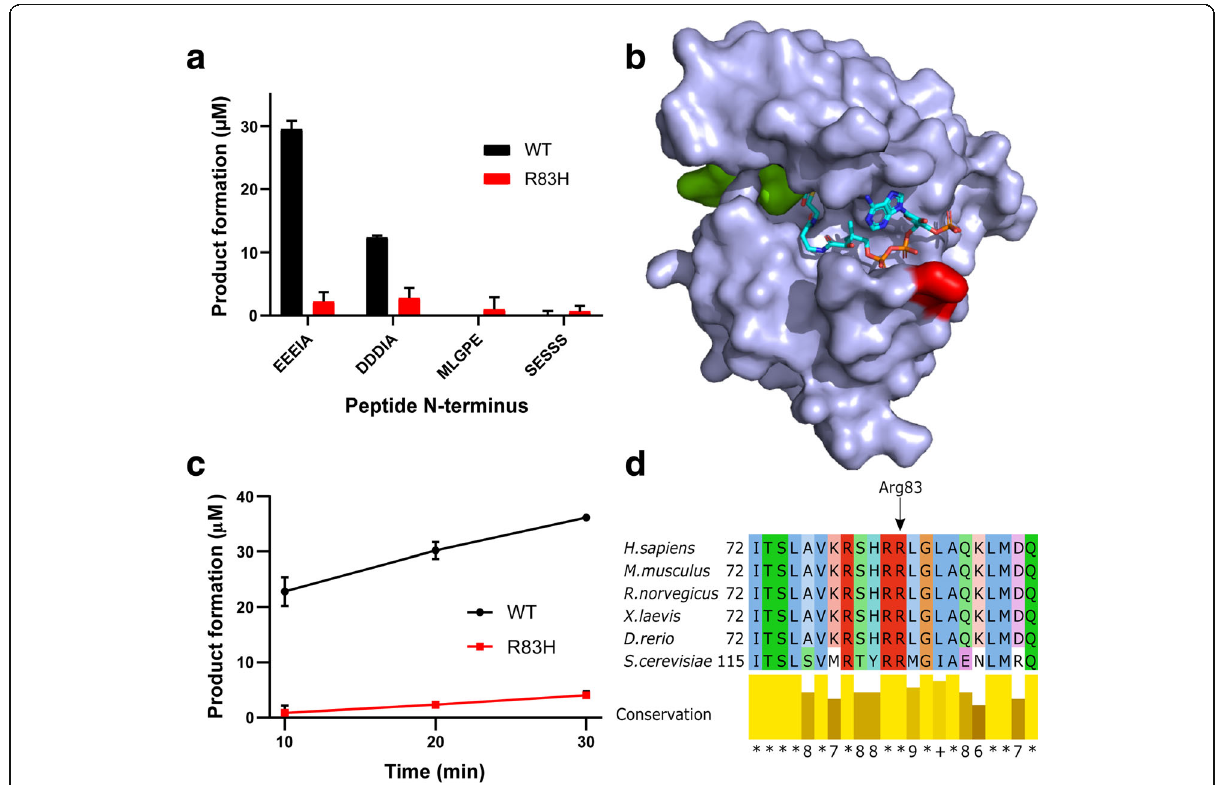
Fig. 2 Functional testing of NAA10-R83H. MBP-NAA10 fusion proteins (wild-type (WT) or R83H) were tested for in vitro NAT activity against substrate peptides with indicated N-termini a or against EEEIA-peptide for the indicated reaction times c . Sequences of the peptide substrates are EEEIAAL RWGRPVGRRRRPVRVYP, DDDIAAL RWGRPVGRRRRPVRVYP, MLGPEGG RWGRPVGRRRRPVRVYP, and SESSSKS RWGRPVGRRRRPVRVYP (bold indicating the variable N-termini of the peptides, while the rest of the peptide sequence is identical between them). b Structure of the human NAA10 protein (PDB ID: 6C9M) superimposed on the substrate from the Schizosaccharomyces pombe NAA10 structure (4KVM) Substrate peptide (SASE) is shown in green, while the mutation site Arg83 is shown in red. CoA is shown as a licorice model colored according to element. d Multiple sequence alignment of NAA10 from Homo sapiens , Mus musculus, Rattus norvegicus, Xenopus laevis, Danio rerio , and Saccharomyces cerevisiae . Conservation score is calculated by Jalview (http://www.jalview.org/), with * signifying perfect